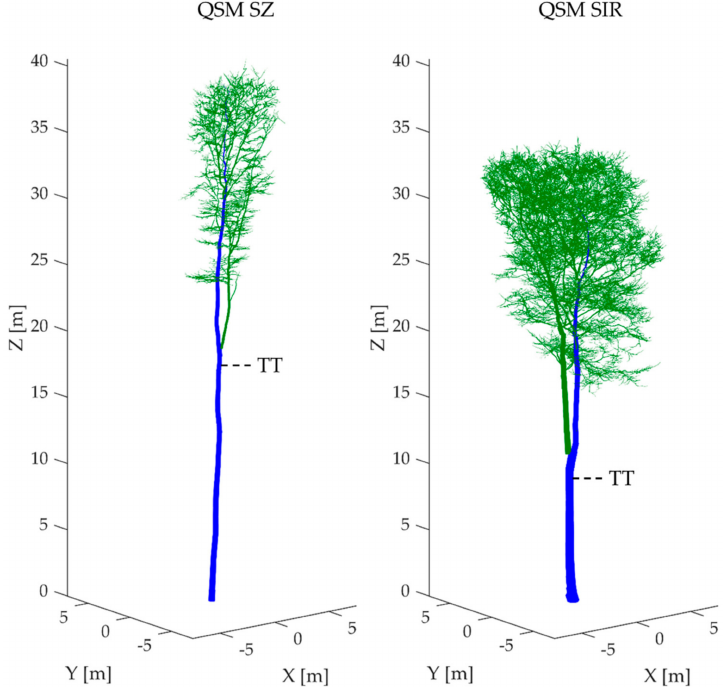
Figure 2. Quantitative structure models (QSM) of European beech trees to illustrate the measuring point for the taper top height (TT). The tree on the right displays an example for the TT measurement in forked trees. The wood volume of the branch-free trunk (V bft ) was determined for the stem section up to TT. The trunk, as determined by the TREEQSM software, is shown in blue. The branches of different orders as defined by TREEQSM are shown in green. The left tree is growing in the long-term unmanaged stand Schattiner Zuschlag (SZ; TT: 18.0 m), the right tree in the intensively managed stand Sirksfelder Zuschlag (SIR; TT: 9.1